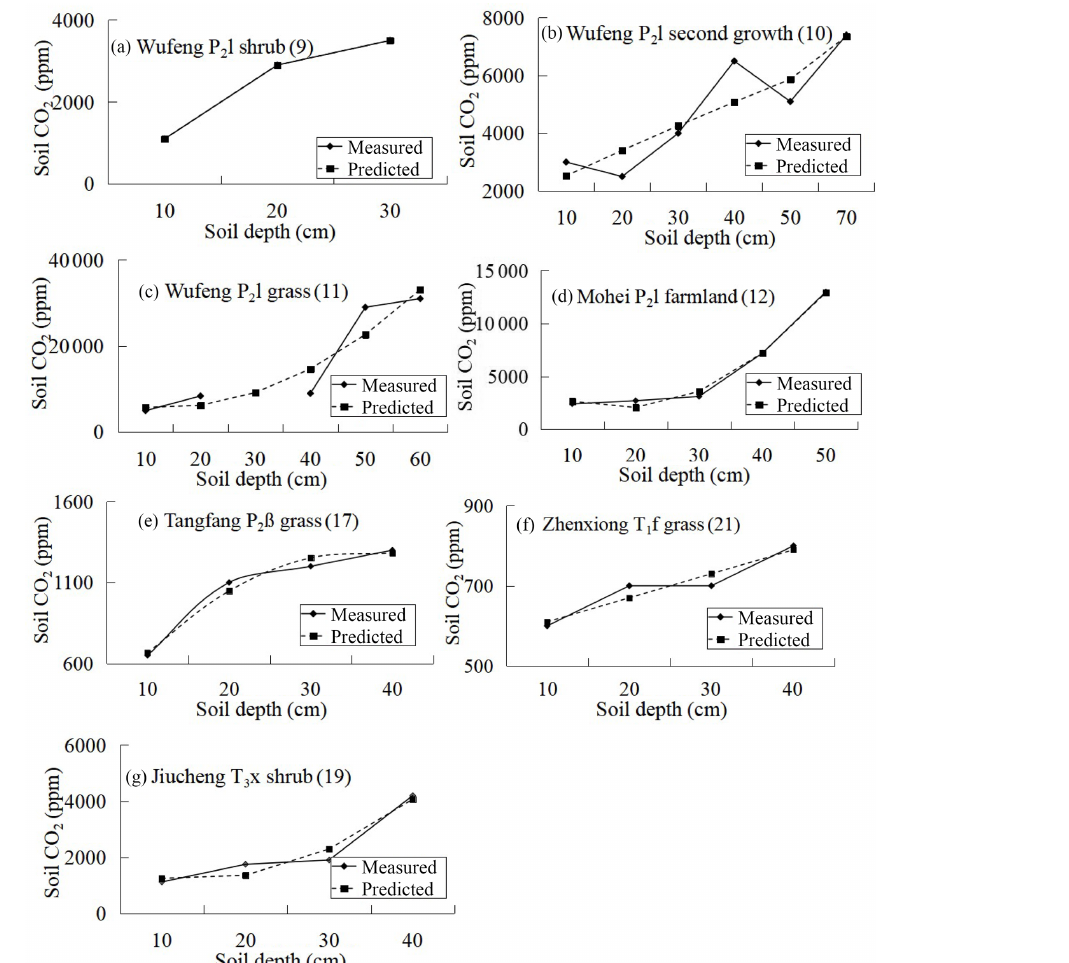
Figure 7. The measured and the simulated CO 2 concentrations of soil profiles in noncarbonate